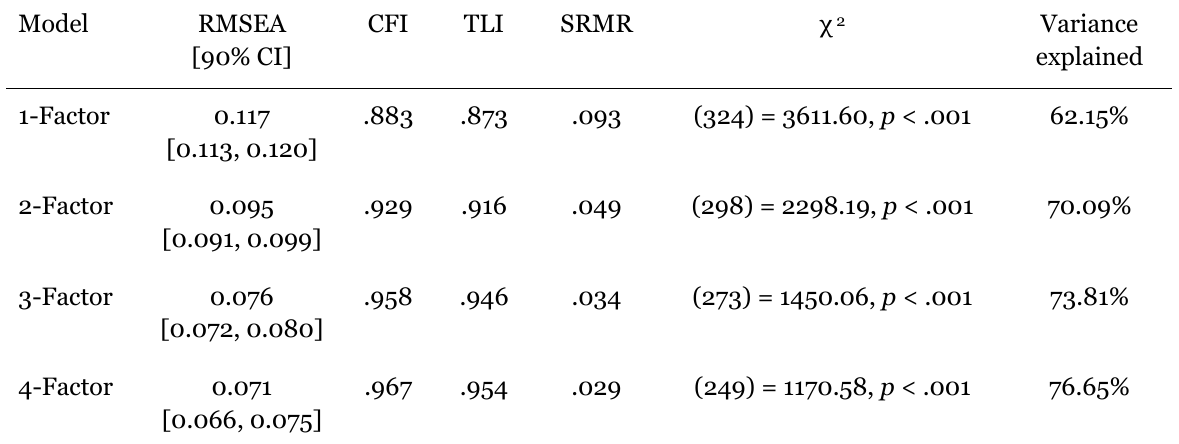
Fit Indices for the Four Exploratory Factor Analysis Models (n = 27 items) Model Variance